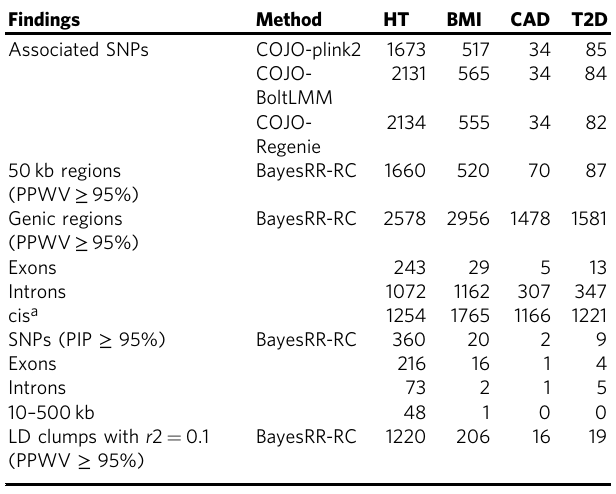
Table 2 Summary of fi ndings for height (HT), body mass index (BMI), type-2 diabetes (T2D) and cardiovascular disease